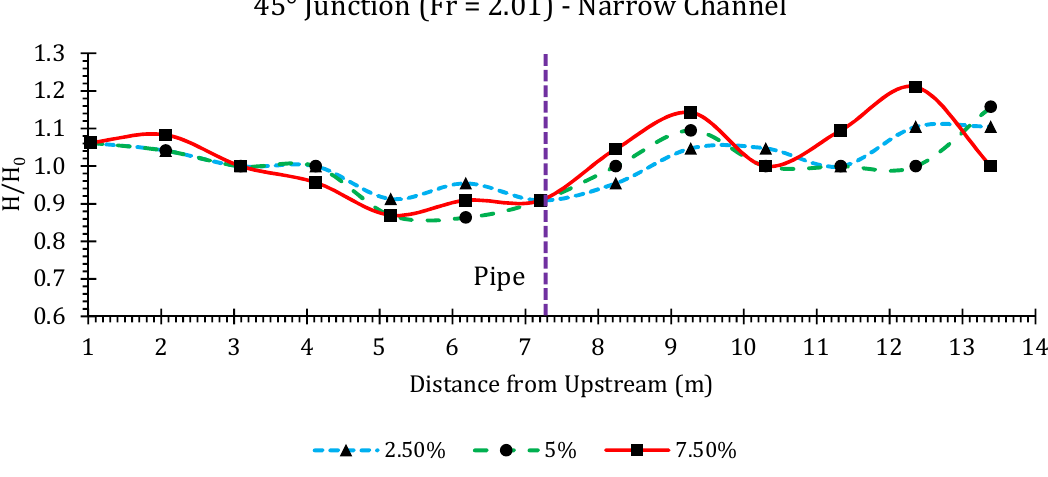
Figure A35. Water height ratios in a 45 ◦ junction for Fr = 2.01 in the narrow Figure A35. Water height ratios in a 45° junction for Fr = 2.01 in the narrow channel. Figure A35. Water height ratios in a 45° junction for Fr = 2.01 in the narrow channel. Figure A35. Water height ratios in a 45° junction for Fr = 2.01 in the narrow channel.